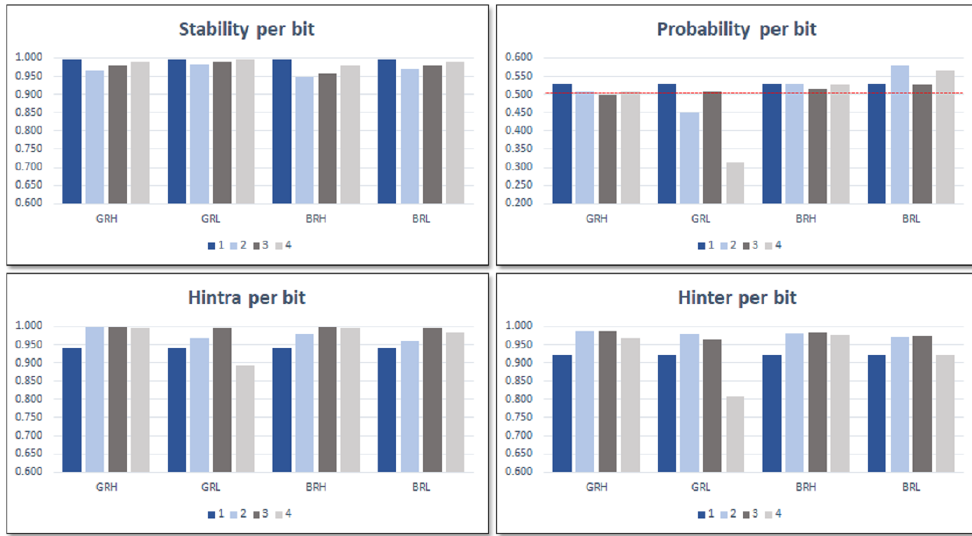
Figure 10. Average stability, probability, and entropy per bit associated with the bits selected for ID generation using different configurations in test systems implemented in operation mode. The red line corresponds to the ideal proability